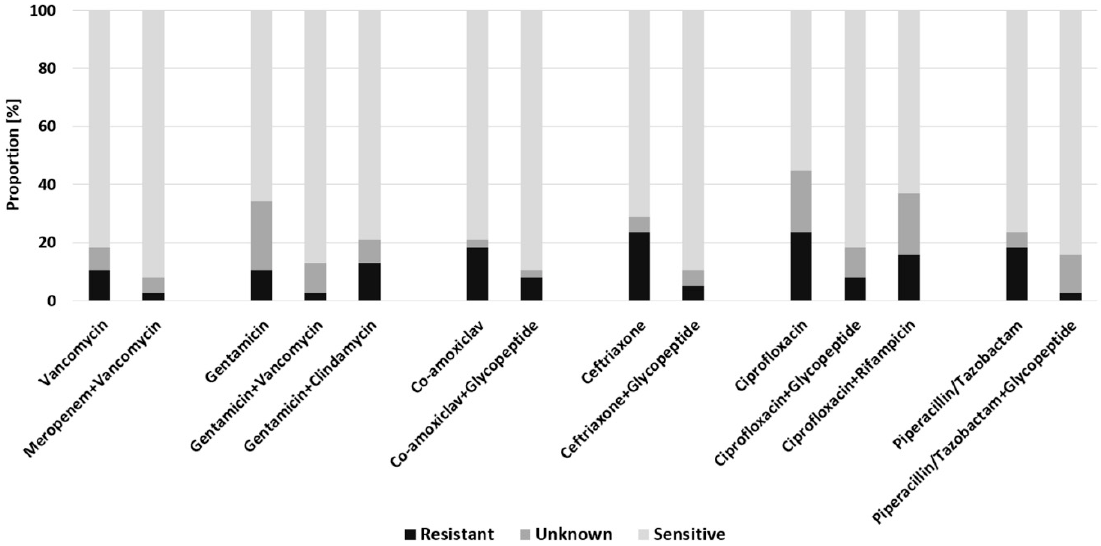
Figure 4. Predicted efficacy of empiric antimicrobial regimens for patients with late-onset of infec- tion.